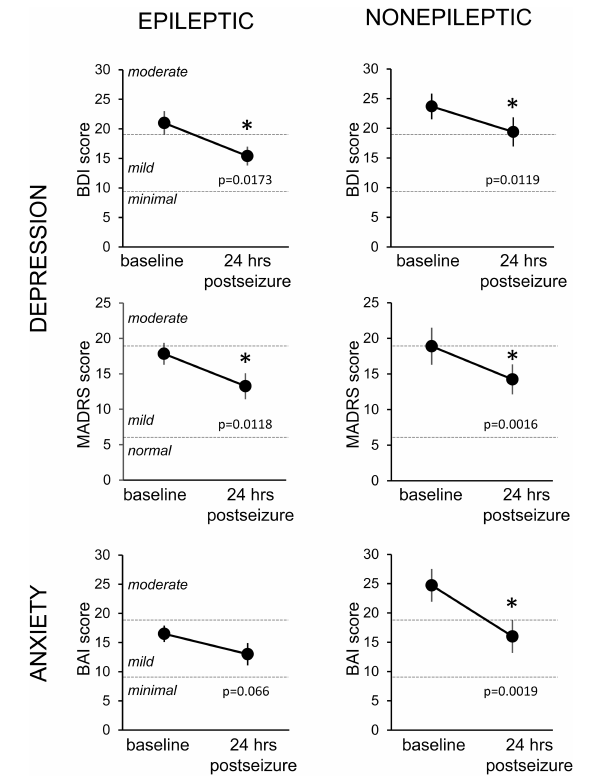
FIGURE 3 | Changes in depression and anxiety symptoms in the 24-h period following an epileptic or non-epileptic seizure. Depression symptoms as assessed with the Becks Depression Index-II (BDI, upper row, n = 15 ES, 14 NES) and the Montgomery-Asberg Depression Rating Scale (MADRS, middle row, n = 25 ES, 18 NES) at baseline, upon entry to the EMU, and in the 24 h following an epileptic (left column) or non-epileptic (right column) seizure. Anxiety symptoms were evaluated with the Beck Anxiety Inventories (BAI, bottom row, n = 20 ES, 14 NES). Statistically significant improvements in mood scores were seen in all groups except the BAI following epileptic seizures. Data presented as mean ± SEM. * Statistically significant decrease.